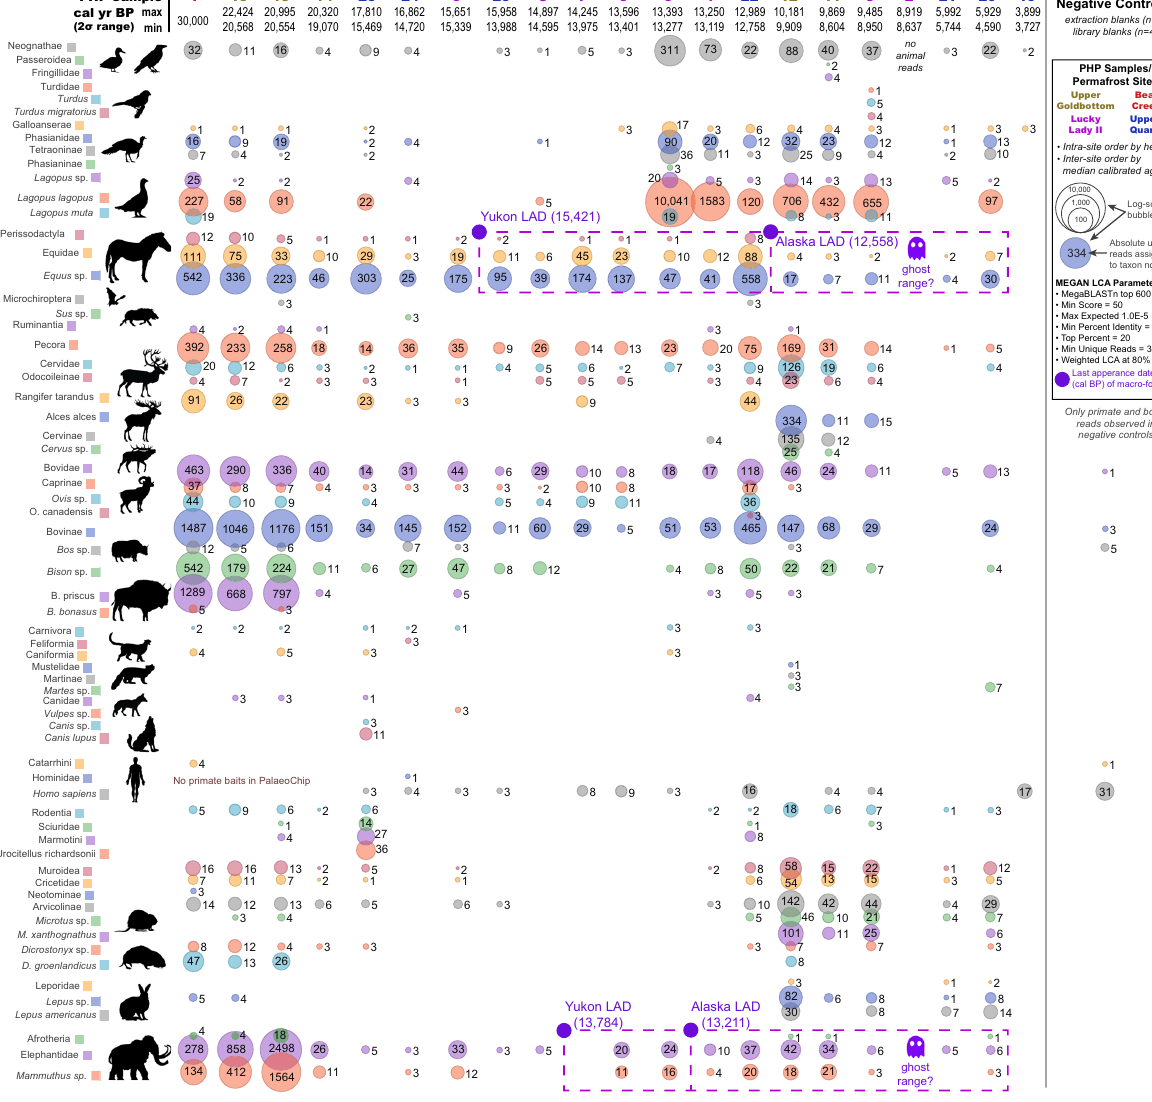
Fig. 2 Metagenomic comparison of animal reads assigned using BLASTn to MEGAN. Values indicate unique reads assigned to that taxon node. Source data are provided as a Source Data fi